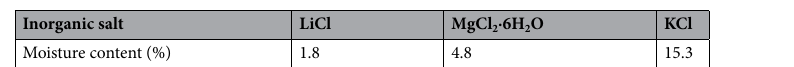
Table 1. Moisture contents of wood controlled by saturated inorganic salt aqueous solution.